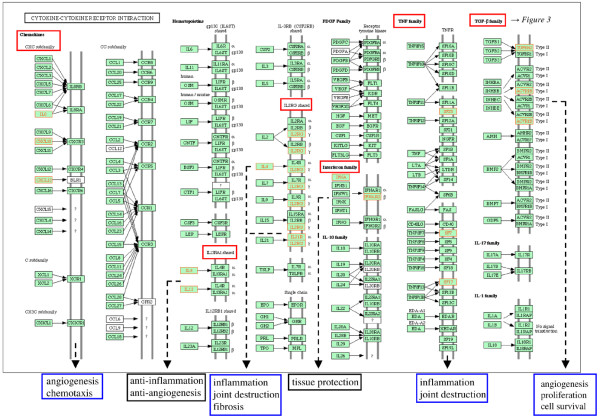
Inter-individual mRNA expression variances among cytokine–cytokine receptor interactions in rheumatoid arthritis (RA) compared with normal control (NC). The graph shows genes affected by significant intra-group inter-individual mRNA expression variances in RA compared with NC (P ≤ 0.05; Bonferroni/Holm corrected Brown-Forsythe version of the Levene test; labeled in red) among Kyoto Encyclopedia of Genes and Genomes (KEGG) cytokine–cytokine receptor interactions, including the respective sub-pathways (P ≤ 0.15, χ2 test; labeled in red). Cellular processes with potential influence on or relevance for RA pathogenesis (for example, inflammation, proliferation, and cell survival) are labeled in blue, and anti-inflammatory/anti-destructive processes are labeled in black.